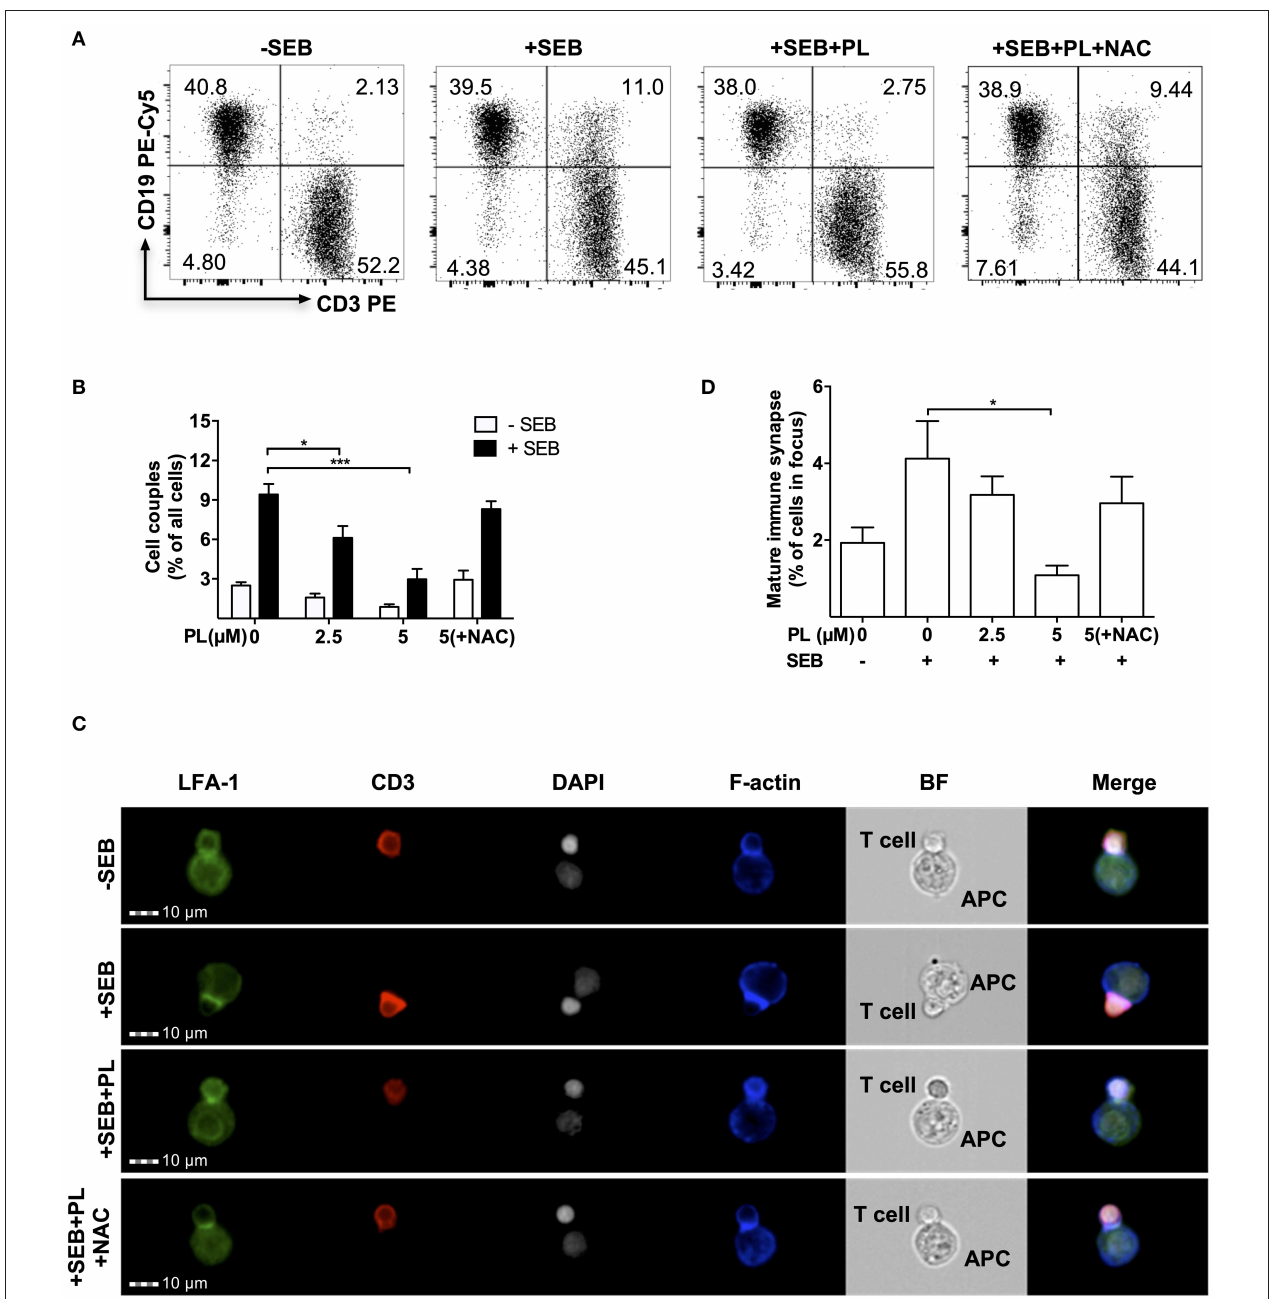
FIGURE 2 | PL interferes with T cell/APC couple formation and immune synapse maturation. (A) Dot plots of T cell/APC couples. Formation of couples was assessed by flow cytometry via CD3 and CD19 staining. T cells were treated overnight without or with 5 µ M PL or 5 µ M PL + NAC (3mM) prior to incubation with APCs in the absence or presence of SEB. The dot plots are representative for three experiments. (B) Quantification of the couple formation between T cells and APCs ( n = 3; mean; SEM; * p < 0.05, *** p < 0.001). (C) Formation of mature immune synapses was analyzed by multispectral imaging flow cytometry (MIFC). Cells were stained for LFA-1 (green), CD3 (red), nuclei (DAPI, white), and F-actin (blue). BF represents the Bright Field image. The merged images show the digital overlay of all four colors. Images are representative for three experiments. (D) Quantification of mature immune synapses between T cells and APCs ( n = 3; mean; SEM; * p < 0.05).